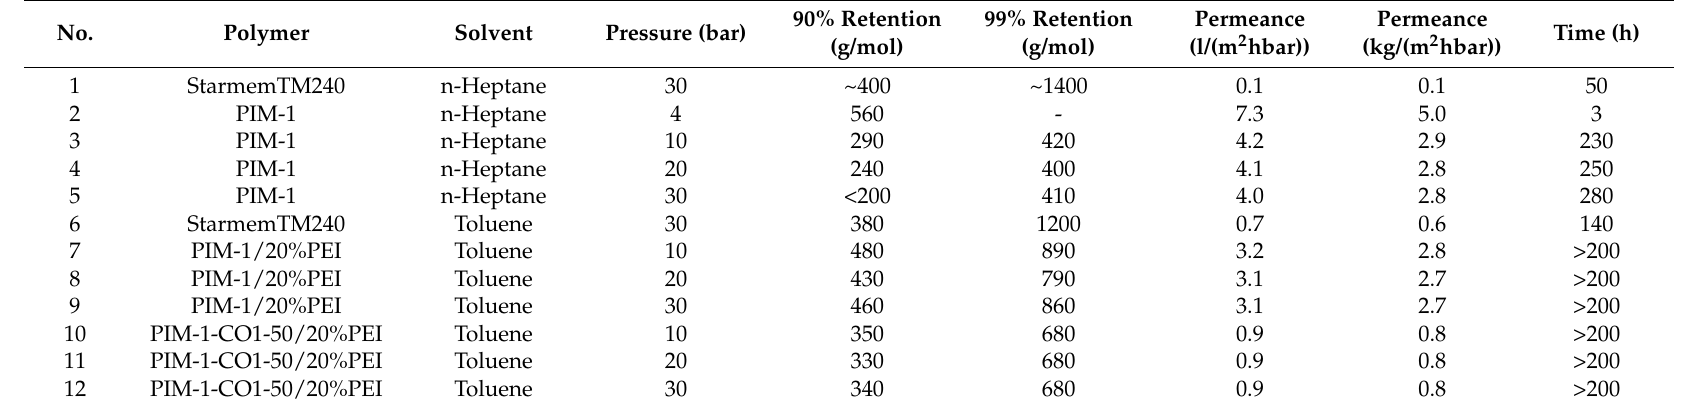
Table 1. Retention characteristics of various membranes, as measured by the retention of a polystyrene mix in n-heptane and toluene. Blend membranes with PEI were thermally crosslinked at 120 ◦ C for 16 h. Reproduced from References